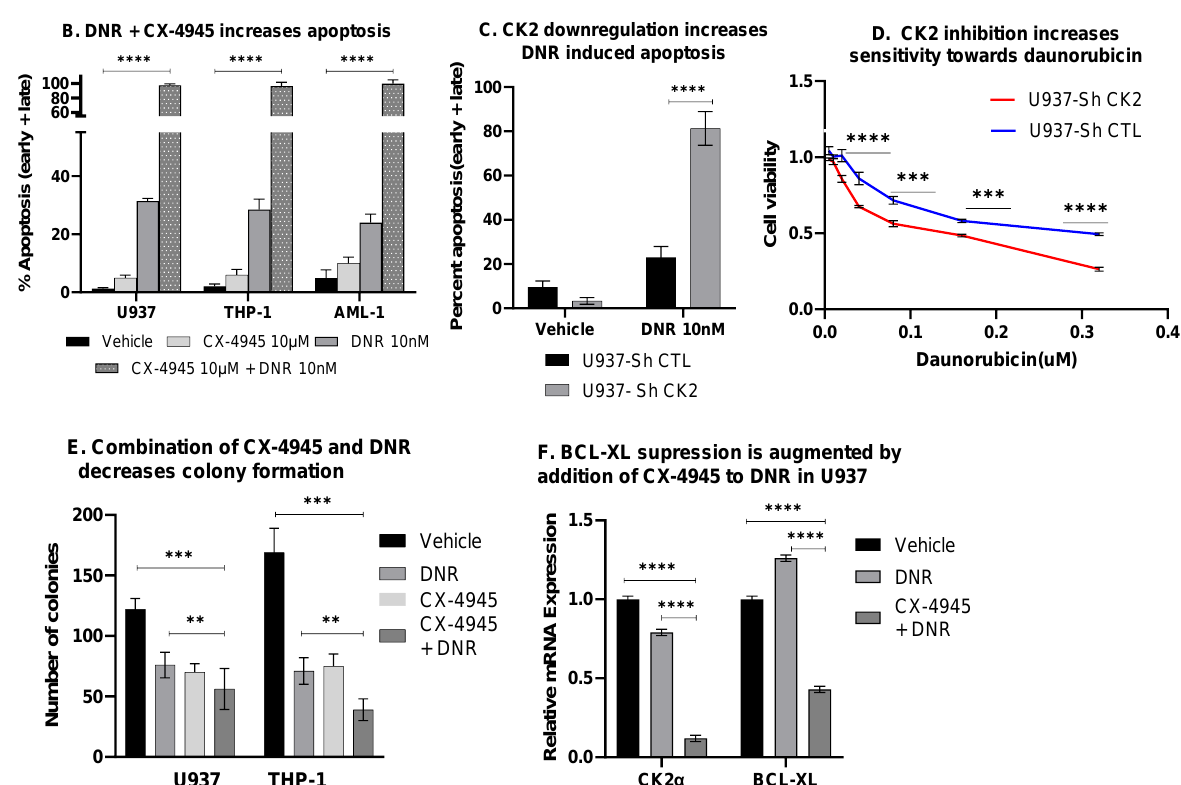
Figure 7. CK2 inhibition potentiates daunorubicin-induced apoptosis in AML cells. Cells were treated with 10 µ M of CX-4945 or a combination of 10 µ M CX-4945 with 10 nM of daunorubicin for up to 48 h. Cells were stained with 7-AAD and Annexin V for flow cytometry to assess apoptosis. ( A ) Flow plots showing representative results from three replicate experiments. The percentage of cells in the right upper and lower quadrant of each flow chart represents the percentage of late and early apoptotic cells, respectively, in U937 (top row), THP-1 (middle row), and AML-1 cells (bottom row) Q1: Dead, Q2: Late apoptosis, Q3: Early apoptosis, Q4: Live. Graphed in ( B ) are the mean +/ SD of triplicates from two independent experiments showing the percent of apoptosis cells following the drug treatment, as indicated above. ( C ) CK2 α silencing in U937 cells achieved using ShCK2 α and sorted for GFP after 24 h. Sorted cells were treated with 10 nM of DNR for 24 h before staining for Annexin V and 7AAD to assess apoptosis. The graph shows the combined percent apoptotic cells (early + late) in each group with and without the DNR treatment. ( D ) Cytotoxic drug response measured by the MTT assay after treating CK2 α ShRNA treated U937 cells and the respective controls with various daunorubicin concentrations for 24 h. ( E ) Cells were pretreated as above for 48 h and were plated in a Methocult medium. Colonies were counted under an inverted light microscope. Colonies that contained around 50 cells or more were counted for analysis. Graphed in Figure 7E is the number of colonies after 14 days as the mean of three replicates +/ SD of two independent experiments. ( F ) The qRT-PCR showing decreases − in the mRNA level in U937 cells treated with daunorubicin alone (10 nM) or a combination of CX-4945 and daunorubicin. p -value summaries are as follows: p > 0.05 (ns); p < 0.01 (**); p < 0.001 (***); p < 0.0001